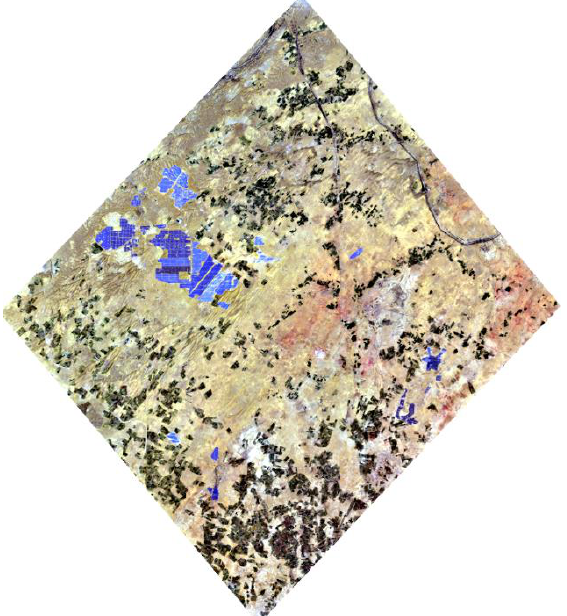
Figure 7: Rectified DESIS data of the study area (RGB: 94, 58, 10).